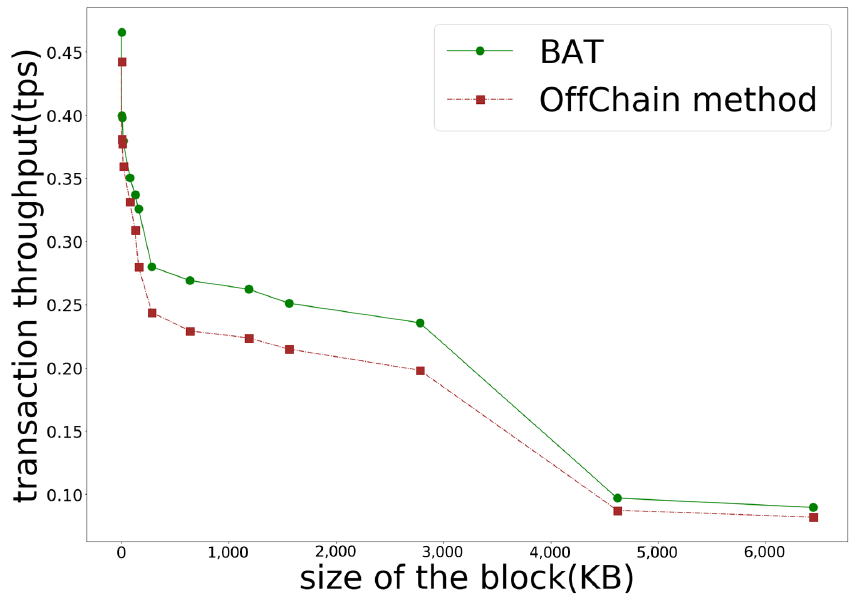
Figure 9. The effect of event processing on transaction processing.